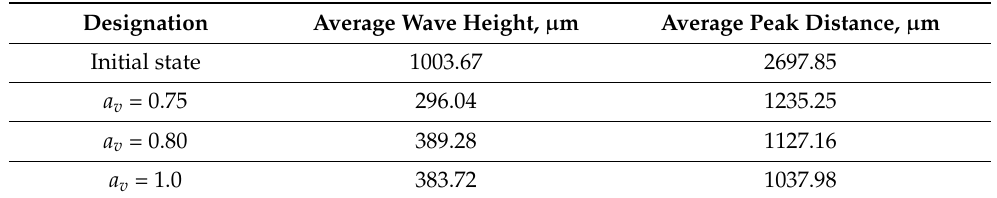
Table 2. Geometric parameters of the joint area of bimetallic sheet metals X2CrNiMo17-12-2 +